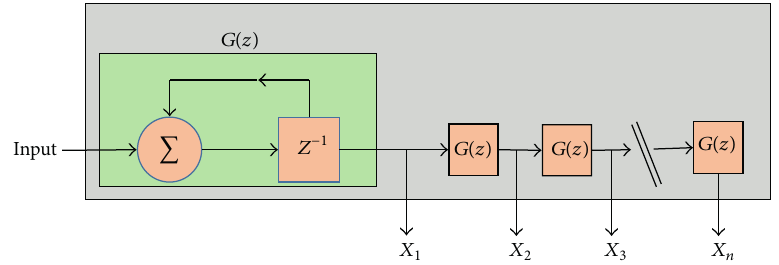
Figure 11: Schema of the gamma memory processing element topology.